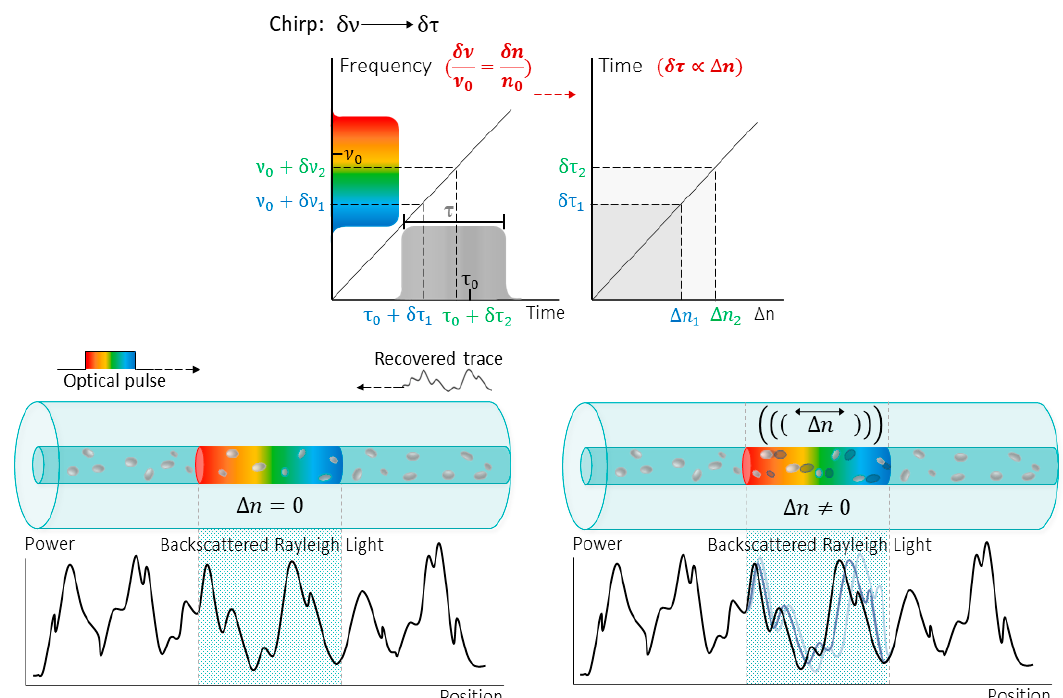
Figure 2. Working principle of chirped-pulses in phase-sensitive optical time domain reflectometry (CP- φ OTDR): A linear frequency chirped pulse is sent into the optical fiber. Scattering centers along the fiber elastically scatter the light, being part of it guided in the opposite direction of the pulse probe with random amplitude and phase. The resulting optical power from the interference of all backscattered light creates the Backscattered Rayleigh trace. This recovered trace can be considered the fingerprint of the fiber, and it changes as the optical path distance (OPD) is changed locally within the fiber (changes in the refractive index or length due to an external stimulus). As stated in Equation (14), a frequency detuning may be used to compensate the change in the OPD, retrieving the original optical power trace (before the perturbation). With the linear chirp, the frequency detuning is mapped into a time delay within the pulse window, so the optical power is recovered as a time delay proportional to the refractive index change.